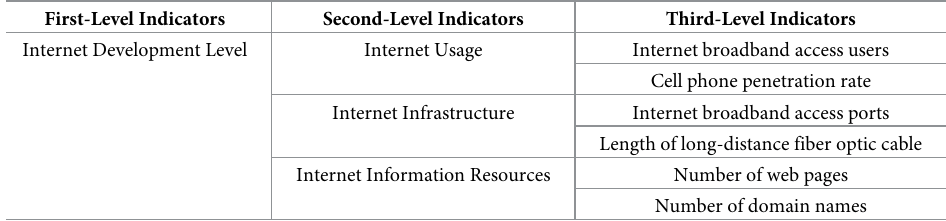
Table 2. Internet development level evaluation index system.